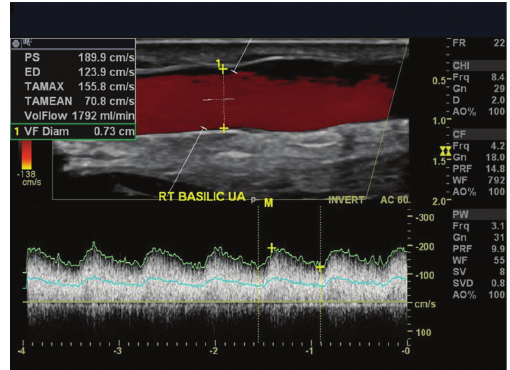
Figure 7: Ultrasound findings indicate this recently created trans- posed basilic fistula is maturing well. The scale to the right of the image confirms that a 5-cm length is superficial enough for easy cannulation, lying 0.5cm or less from the surface of the skin. The diameter measures 0.73 cm. With PSV of 189.9 cm/sec and EDV of 123.9 cm/sec, a volume-flow of 1792 mL/min has been calculated by a software package incorporated into the ultrasound equipment. These details are shown in the upper left hand